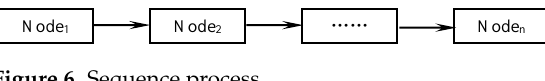
Figure 6. Sequence process.